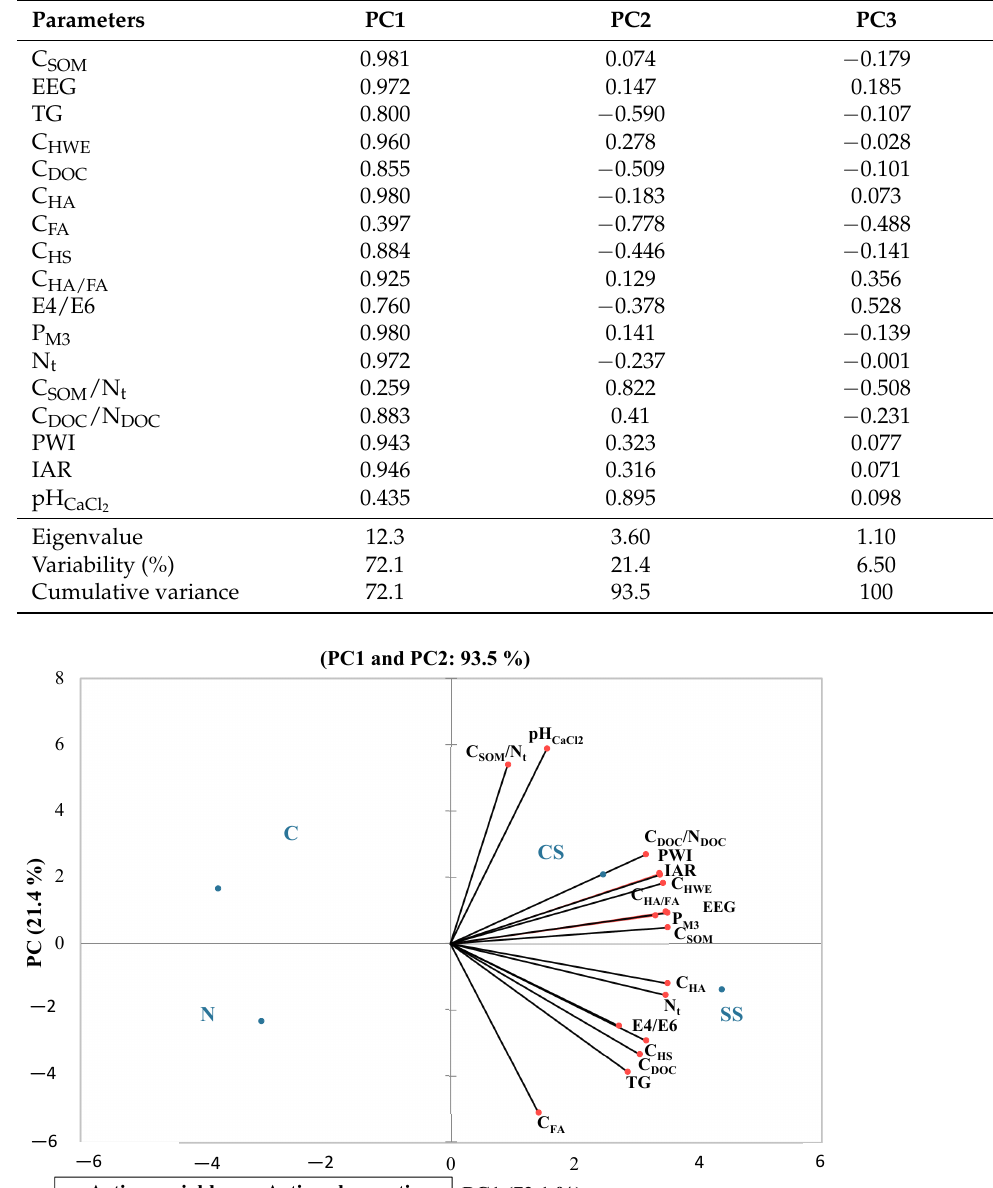
Table 7. The principal components (PCs) or factors and their loading factor values, eigenvalues, and variabilities (%).